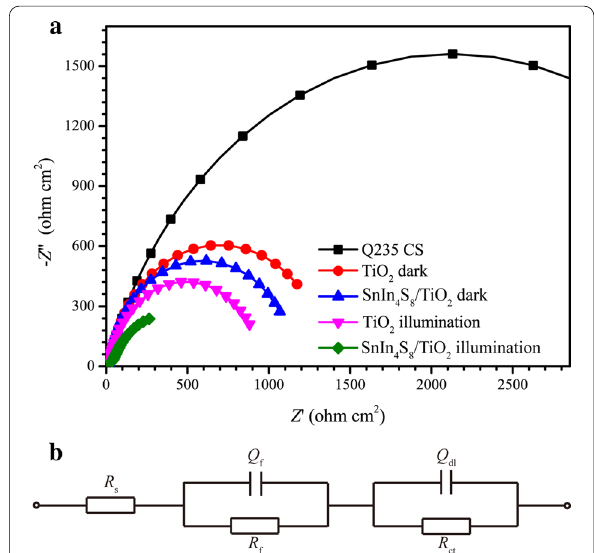
Fig. 10 a Nyquist plots of bare Q235 CS, Q235 CS coupled to TiO 2 NTs film, and SnIn